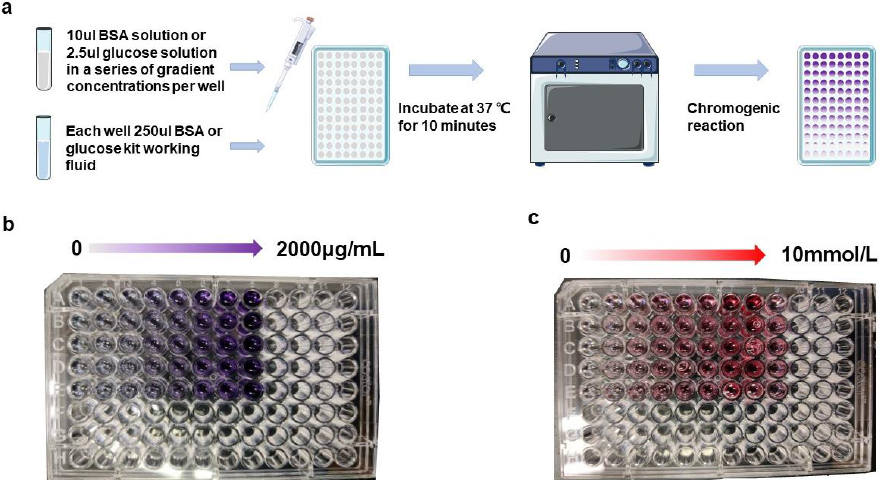
Figure 3. Experimental process of the AHTEMR: ( a ) Flow chart of the BSA color reaction experiment. ( b ) Microplate carrying BSA solution after color development. ( c ) Microplate carrying glucose solution after color development.